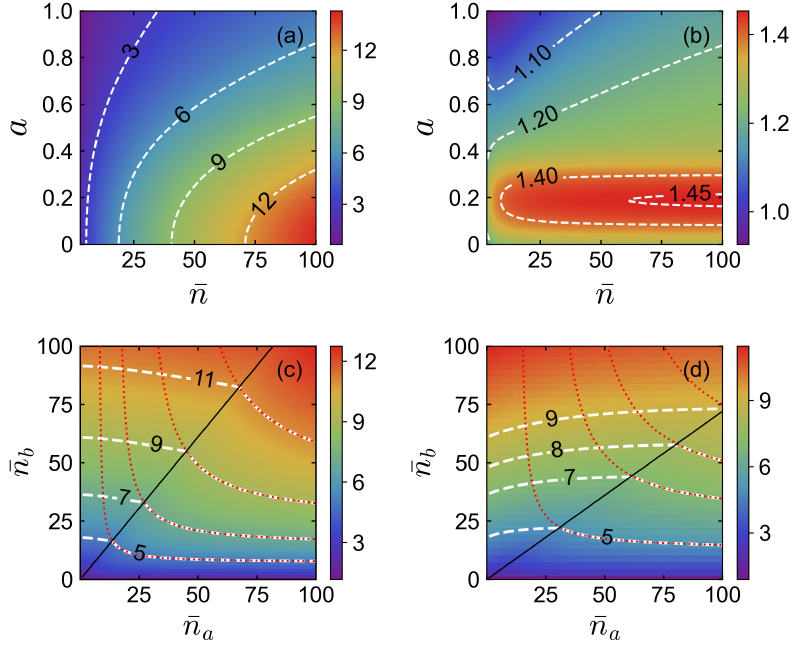
√ ¯ n Figure 2. ( a , b ) Density plots of the ratios 2 π /3 and 1/ as functions of the average photon FWHM δθ CRB,min number ¯ n and the bin size a , with the parameters ¯ n b = 0.687 and (cid:36) = 0.58 [10]; ( c , d ) density plot √ ¯ n of the ratio 1/ against ¯ n a and ¯ n b for (cid:36) = 1 ( c ) and 0.58 ( d ). Red dotted lines: analytic result δθ CRB,min of Equation (23), coincident with the numerical result below the solid lines that determined by √ ¯ n b = 0.55¯ n (cid:36)